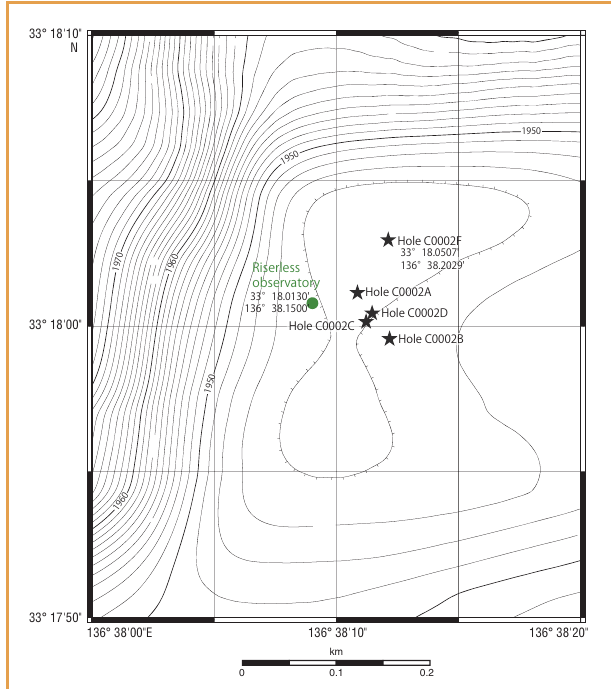
Figure 4. Bathymetric map of Site C0002. Black stars=holes drilled, green circle=proposed hole for Expedition 332 riserless observatory.